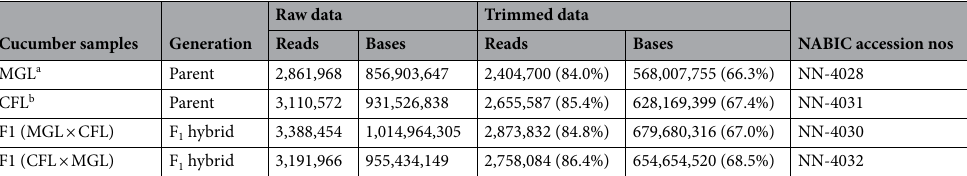
Table 1. Cucumber samples and NGS data used in this study. a Korean solid green type inbred line. b Chinese long green type inbred